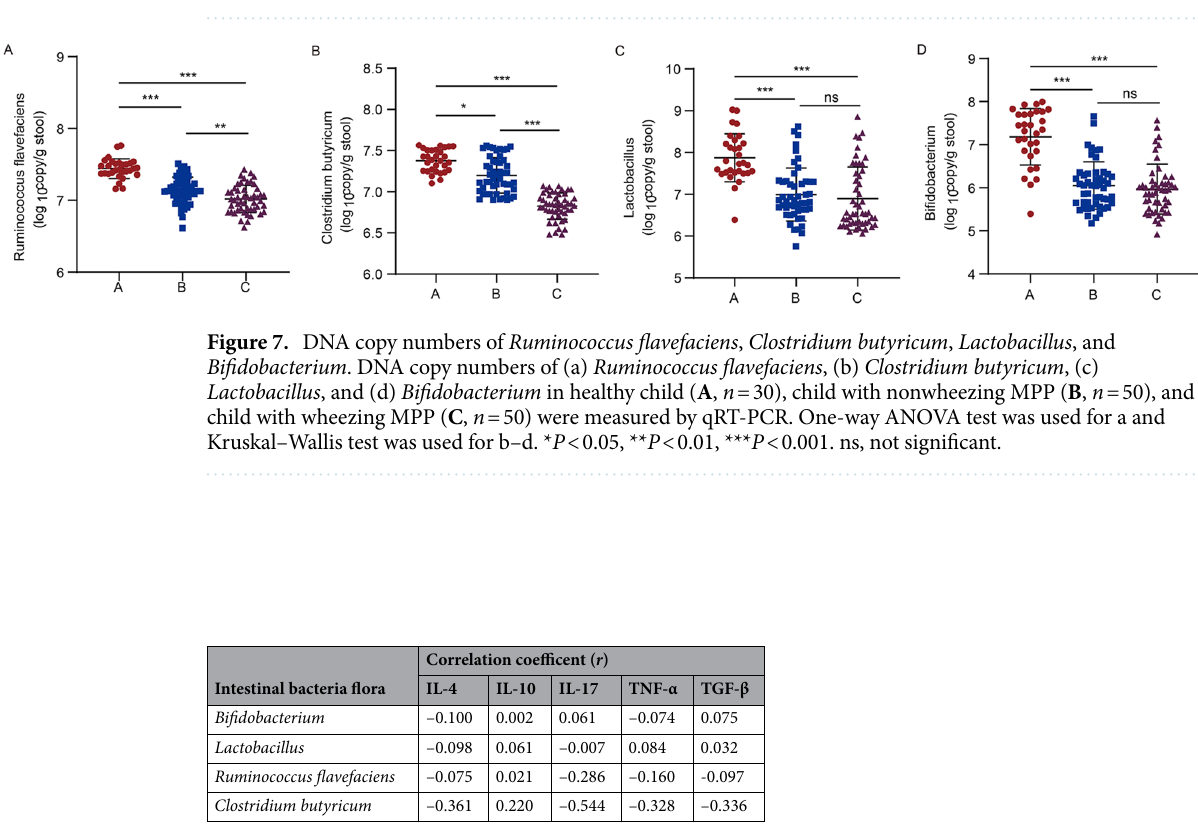
Figure 6. COG functional classification in healthy and MPP patients. Relative abundance of different COG functional classification in healthy child ( A , n = 30), child with nonwheezing MPP ( B , n = 50), and child with wheezing MPP ( C , n = 50). Heatmap of top 30 abundant COG functional classification in healthy child ( A , n = 30), child with nonwheezing MPP ( B , n = 50), and child with wheezing MPP ( C , n = 50).